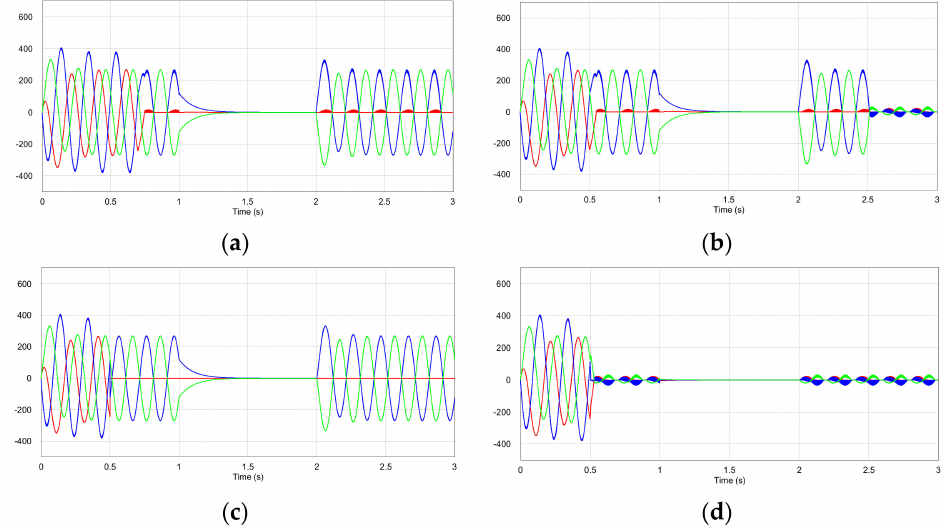
Figure 8. Output currents of electromagnetic stirring power supply without fault tolerance. ( a ) faulty V 1 at t = 0.7 s; ( b ) faulty V 1 at t = 0.5 s and faulty V 4 at t = 2.5 s; ( c ) both faulty V 1 at t = 0.5 s and faulty V 2 at t = 0.5 s; ( d ) faulty V 1 at t = 0.5 s and faulty V 4 at t = 0.5